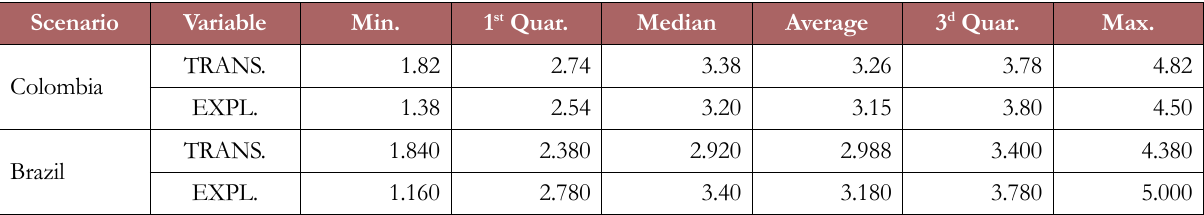
Table 4. Statistical summary of the transformation and exploitation ratings in Medellín and Minas Gerais’ innovative enterprises